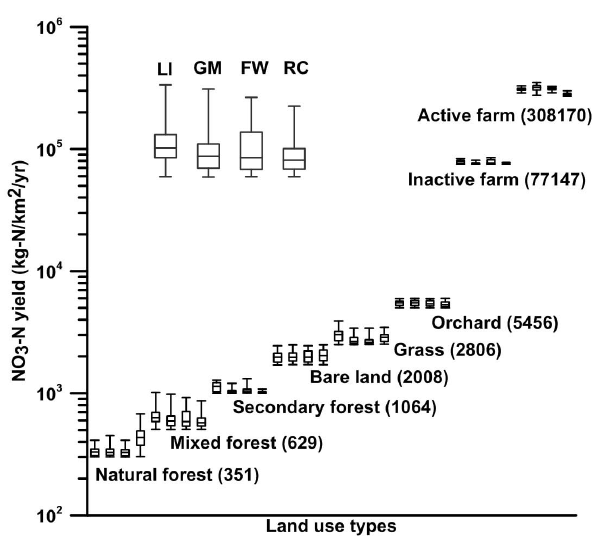
Fig. 6. The landuse-associated NO 3 -N yields. Four box-whisker plots for each landuse type stand for the inverse calculation of landuse-associated yields based on the sub-catchment outlets’ yields derived from LI, GM, FW, and RC